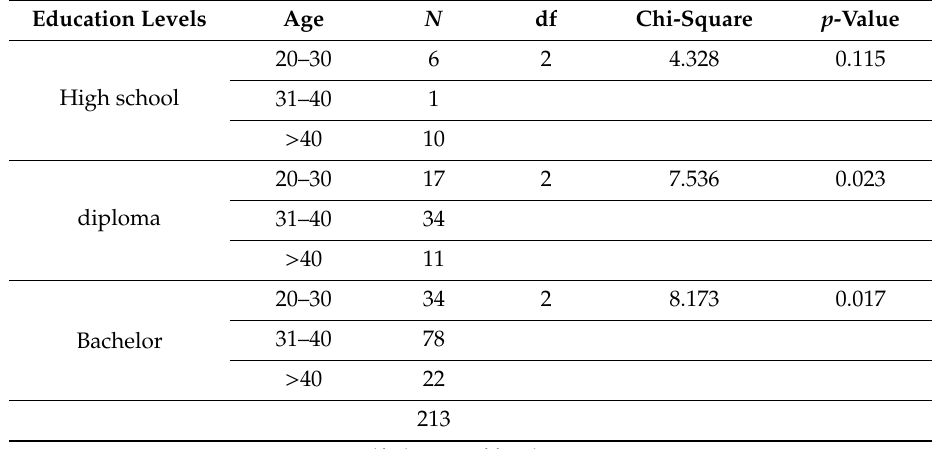
Table 5. Kruskal–Wallis Test (K–W) test for religious belief (age with education levels).